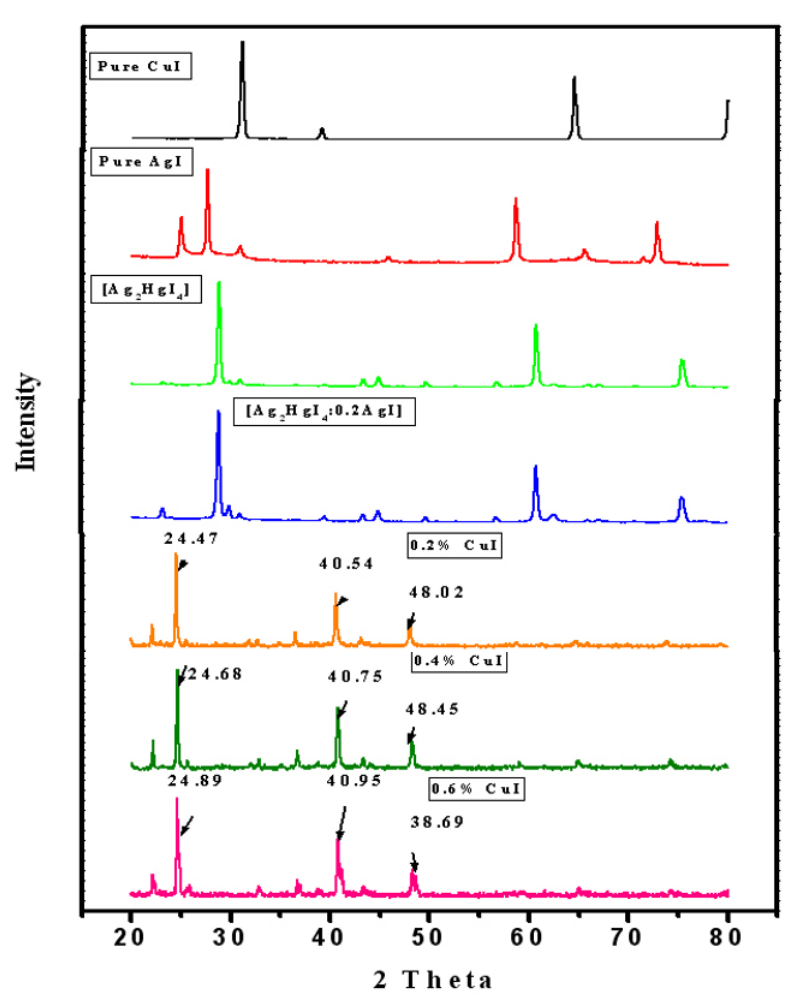
Figure 1. Log σ T vs. the mol.% plot of CuI in the [Ag